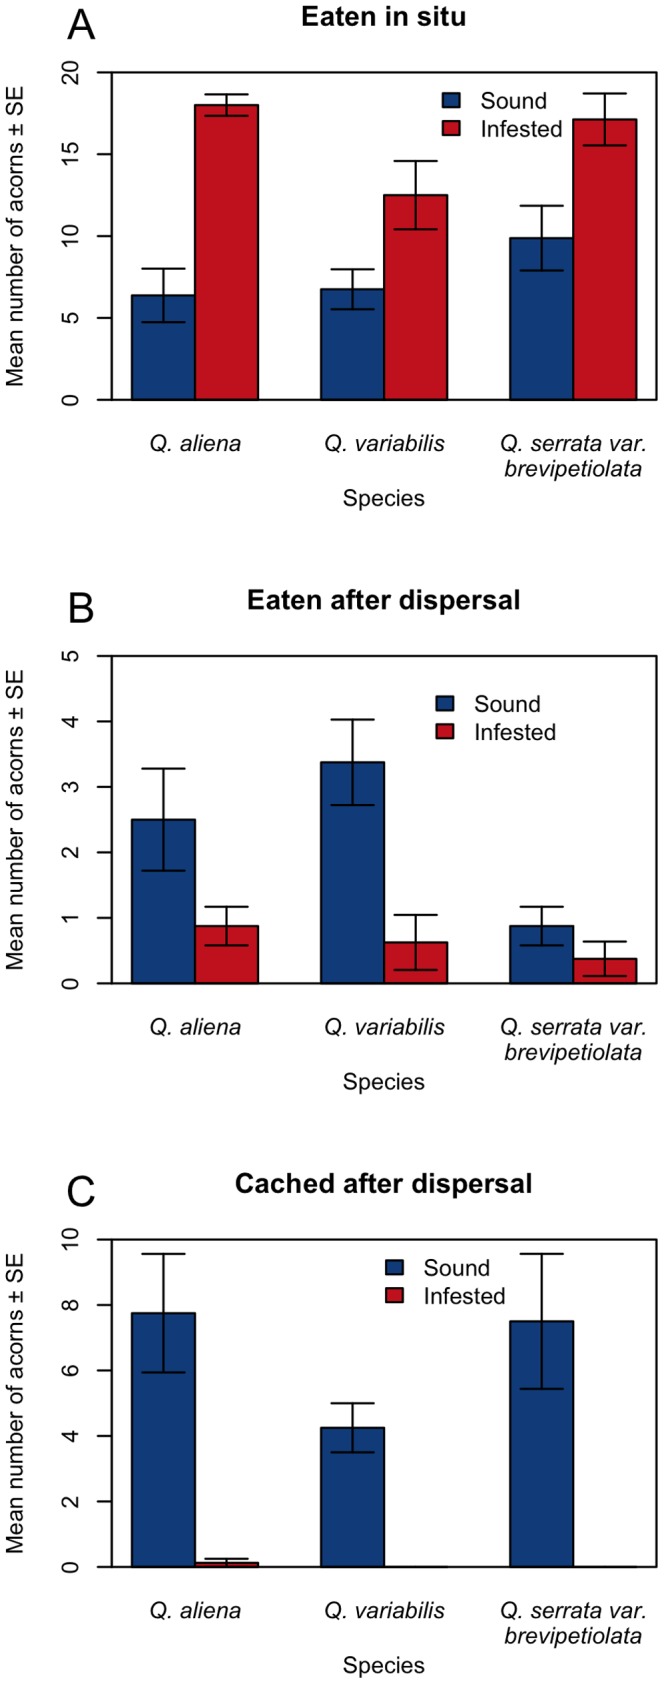
Seed fate of sound and infested acorns of Q. variabilis, Q. aliena, and Q. serrata var. brevipetiolata after being manipulated by Siberian chipmunks.A, B, and C indicate eaten in situ (EIS); eaten after dispersal (EAD), and cached after dispersal (CAD). Data are expressed as mean ± SE.